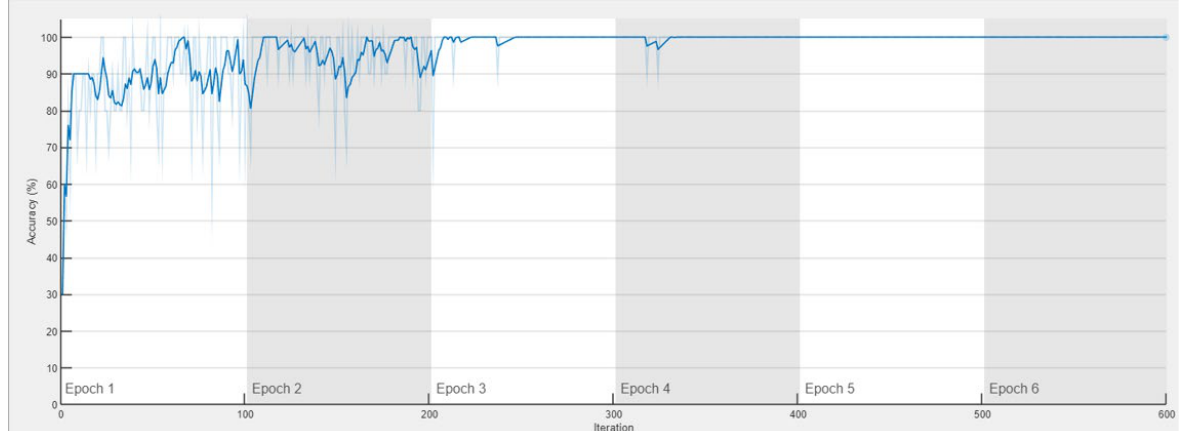
Figure 13. Training accuracy . Figure 13. Training